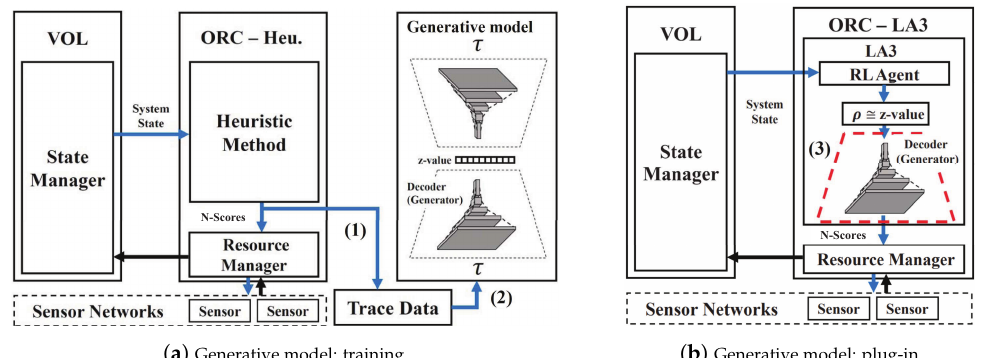
Figure 7. LA3 with the generative model: ( a ) The model is first trained to learn the features of N -scores from the trace data for relatively large N . Its decoder is then placed for LA3 ’s action transformation ( b ). As a result, the action space size of the RL agent becomes | ρ | (cid:28) N